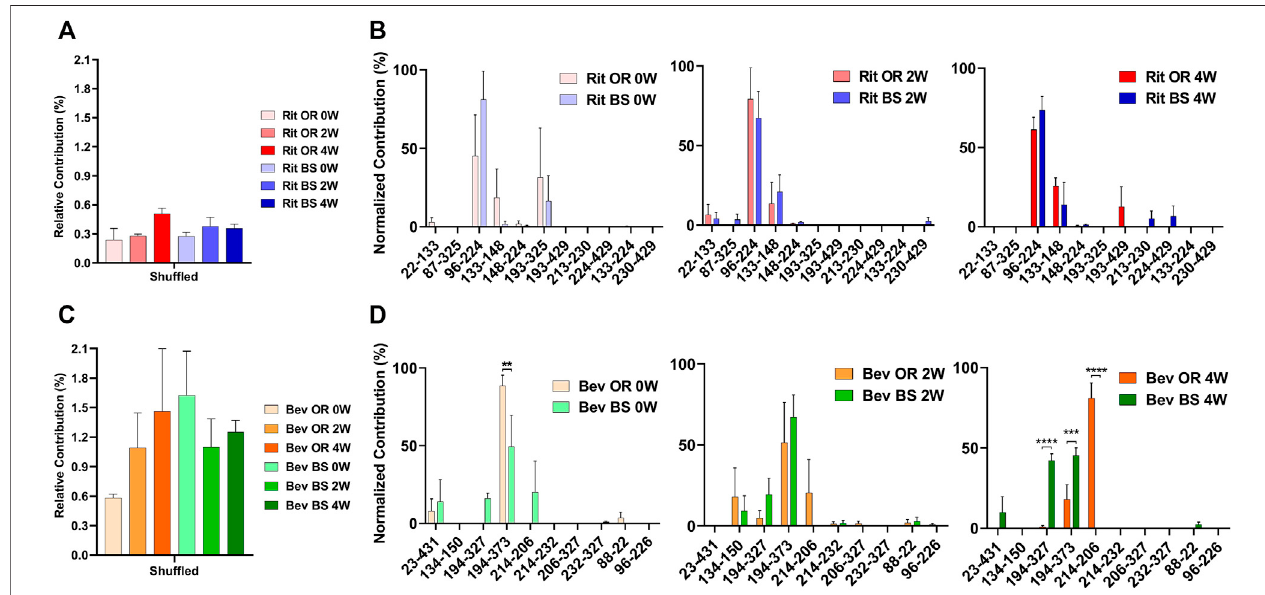
FIGURE 3 | Total shuf fl ed bond contribution relative to the XIC sum of all identi fi ed disul fi de bonds for (A) rituximab originator and biosimilar and (C) bevacizumab originator and biosimilar. Prevalence of the shuf fl ed bond locations normalized to the total number of shuf fl ed bonds for (B) rituximab originator and biosimilar and (D) bevacizumab originator and biosimilar ( N = 3, mean ± SD, 2-way ANOVA, * p < 0.05, ** p < 0.01, *** p < 0.001, **** p <